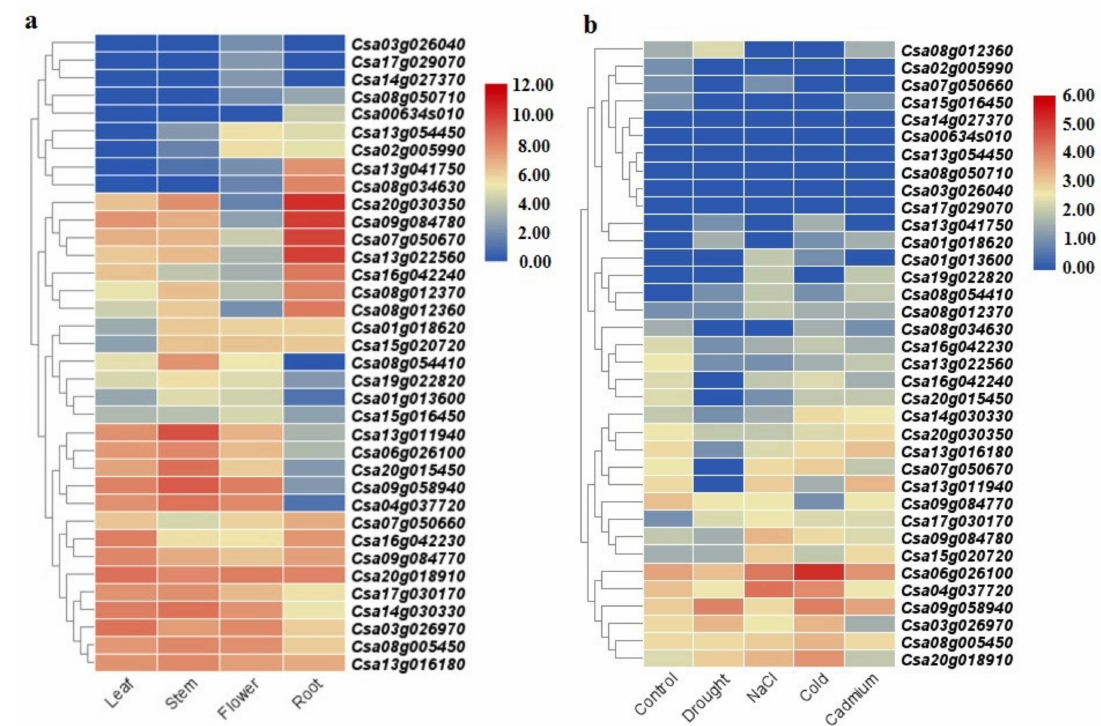
Figure 7. The expression levels of the SULTRs in C. sativa , based on the available RNA-seq data: ( a ) in different tissues; ( b ) in response to abiotic stresses.